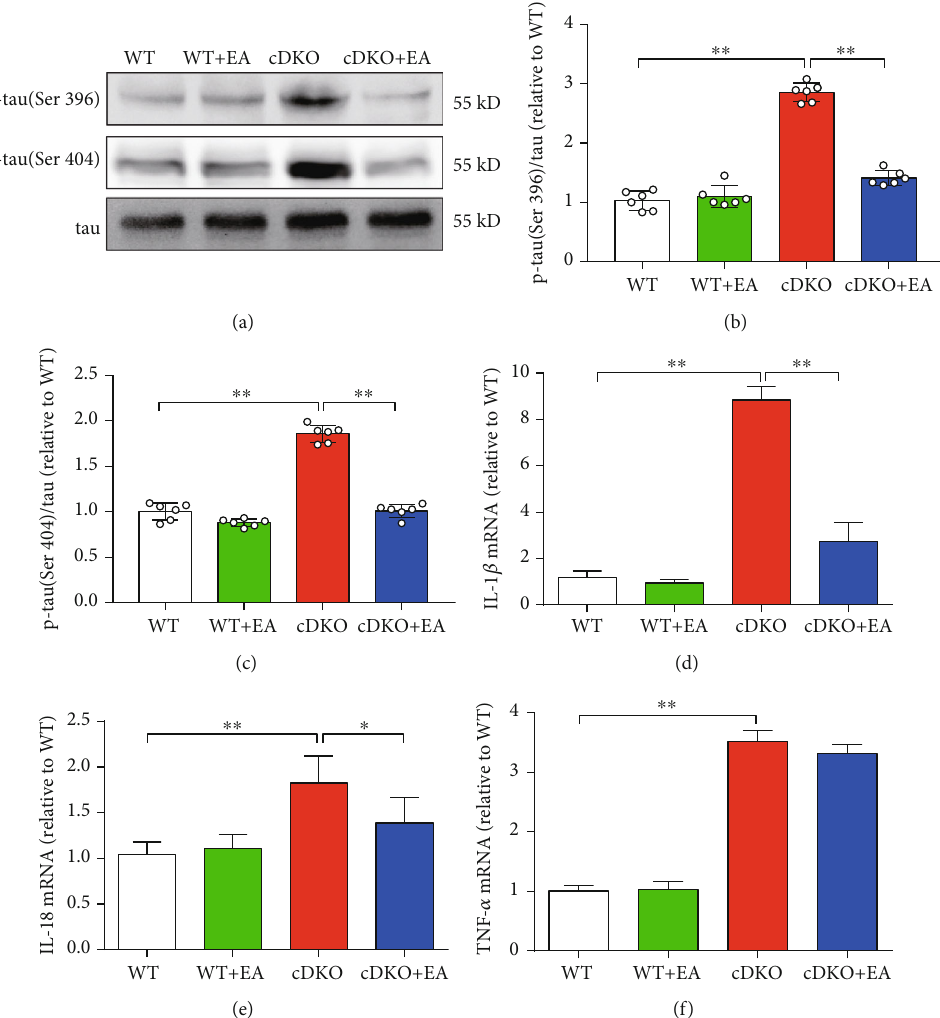
Figure 3: EA treatment inhibits tau hyperphosphorylation and elevated in fl ammatory response in the hippocampus of PS cDKO mice. (a) Representative Western blot of phosphor-tau (Ser396/Ser404) in the hippocampus. (b, c) Quanti fi cation of Western blot for p-tau in the hippocampus ( n = 6 mice for each group). The protein levels of p-tau were normalized with the levels of their respective total tau. The values were expressed as relative changes to the respective WT mice, which was set to 1. (d) – (f) Quantitative mRNA levels of IL-1 β , IL- 18, and TNF- α in the hippocampus by qRT-PCR ( n = 5 mice for each group). The mRNA levels were standardized based on the respective level of β -actin. Values were expressed as relative changes to WT mice, which was set to 1. Data are the mean ± S : E : M : , ∗ p < 0 : 05 , ∗∗ p < 0 : 01